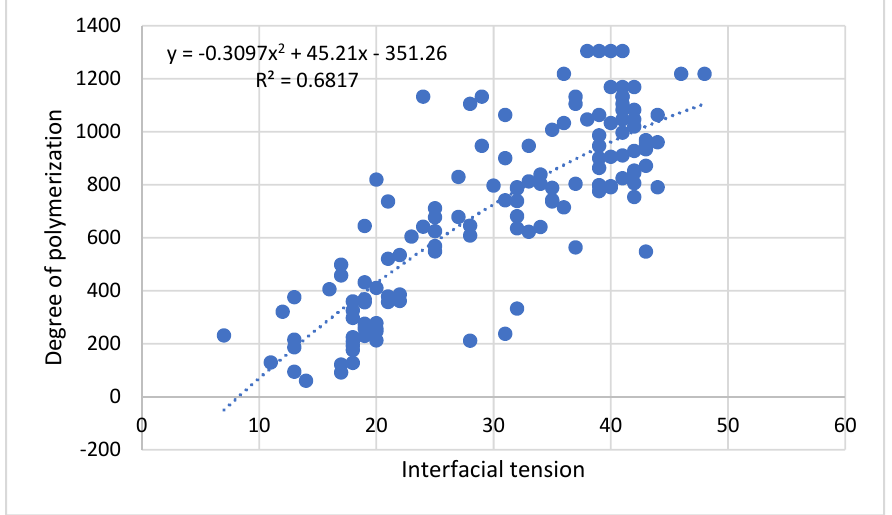
Figure 3. Fitting line as a polynomial explaining the relation between DP and IF.